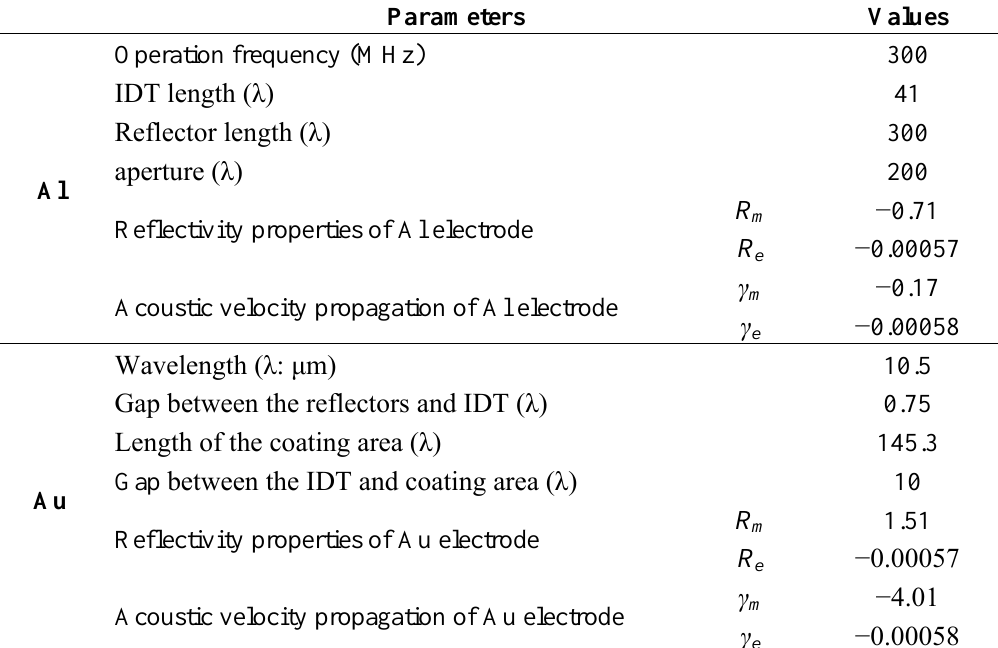
Figure 4. The PCB of SAW oscillation circuit.